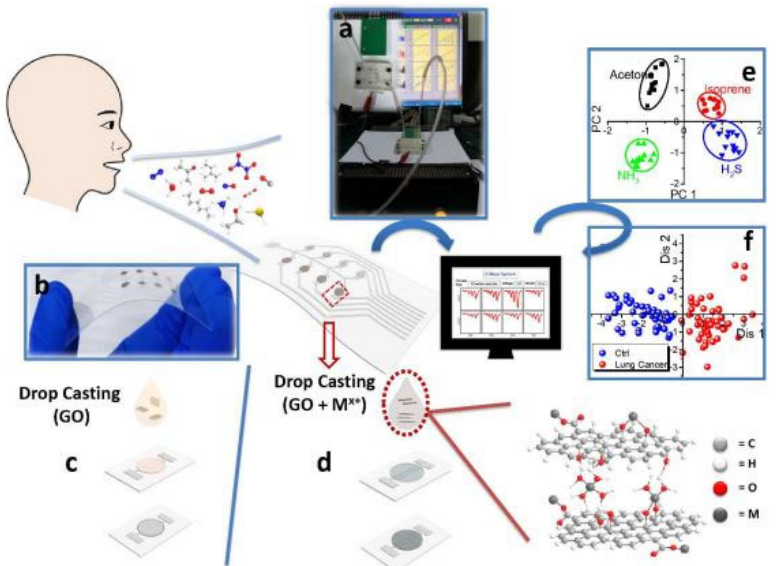
Figure 7. An overview of e ‐ nose system comprising the metal ion induced assembly of rGO; ( a ) E ‐ nose system photograph, ( b ) rGO ‐ m, ( c ) Drop casting comparison of GO, ( d ) M x+ induced assembled GO, ( e ) Pattern recognition by PCA, ( f ) clinical EB analysis by linear discrimination analysis. Re ‐